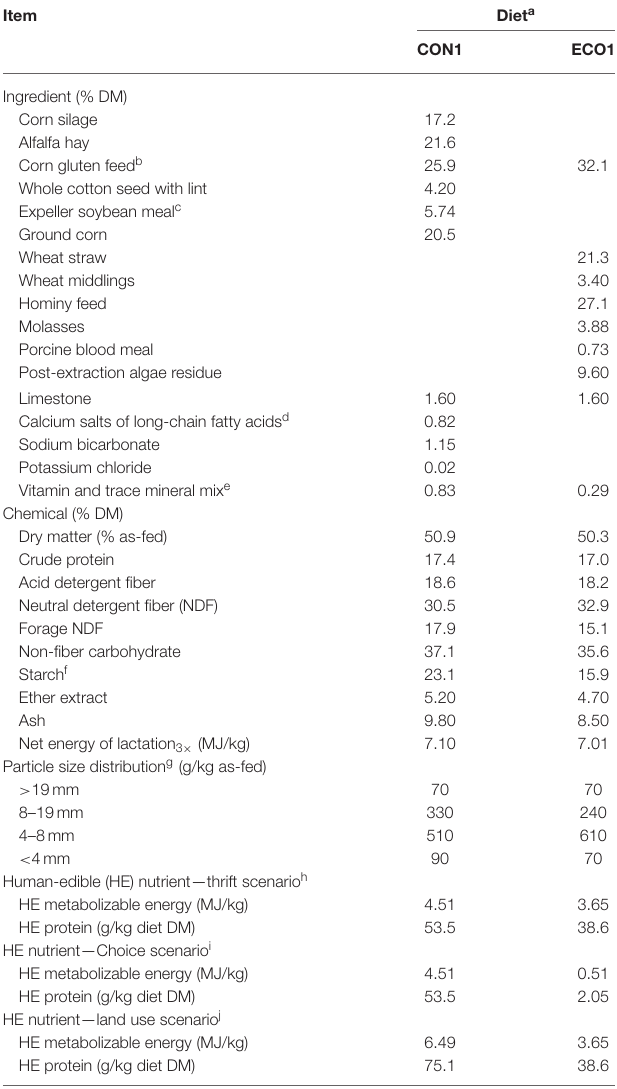
TABLE 1 | Ingredients and chemical composition of diets provided in Experiment 1.